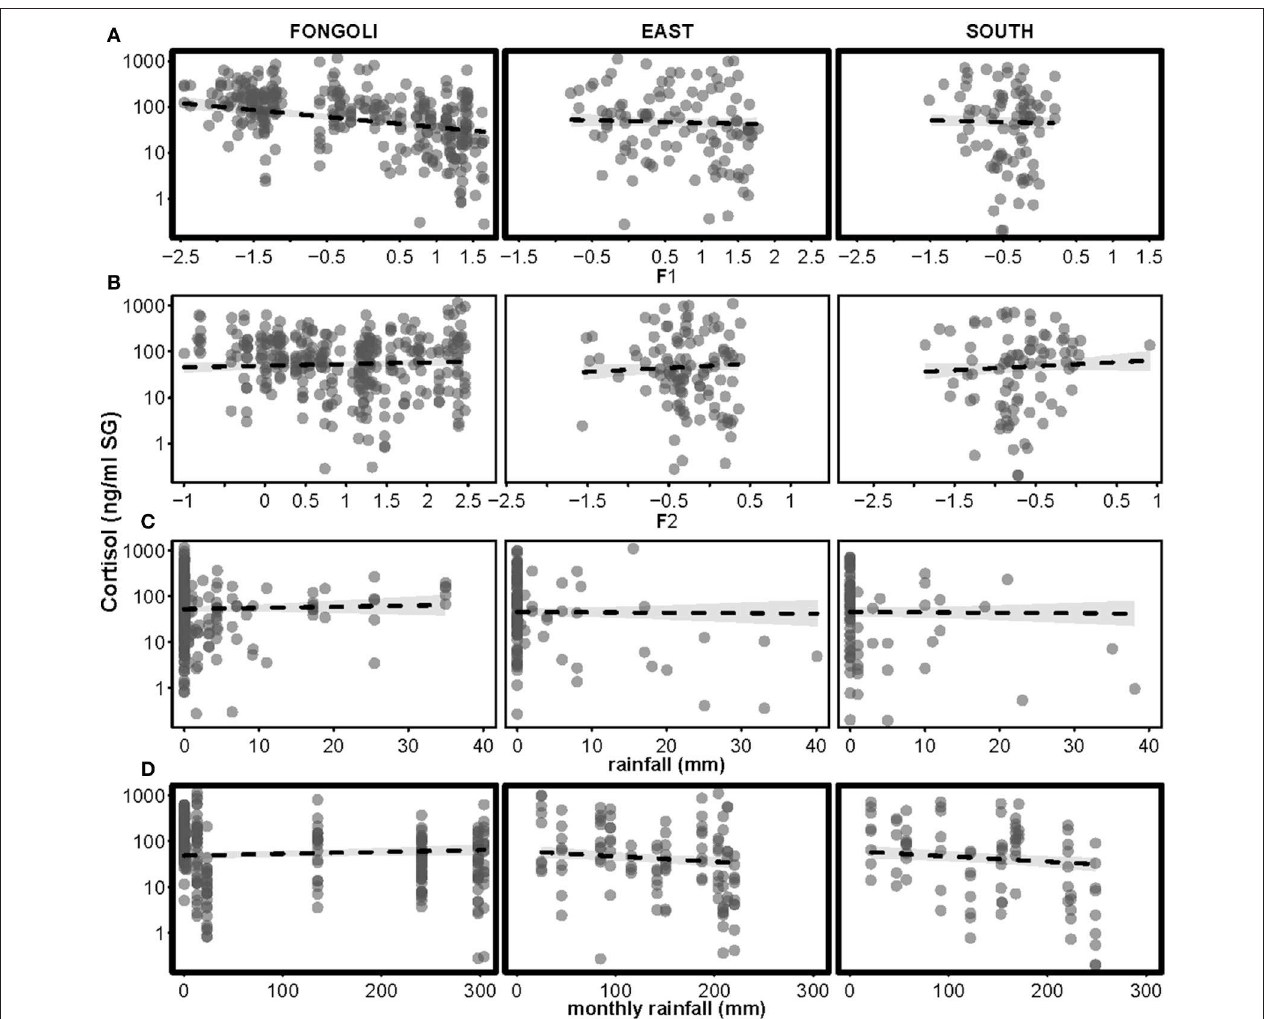
FIGURE 7 | Effects of four environmental variables on urinary cortisol levels in three chimpanzee communities. Environmental variables displayed are: Factor 1 (relative humidity, centered to site; A ), Factor 2 (temperature, centered to site; B ), rainfall (C) , and monthly rainfall (D) . Cortisol levels appear on a logarithmic scale. Statistically significant inter-site differences ( p ≤ 0.05) appear with bold margins; 95% confidence intervals are displayed in